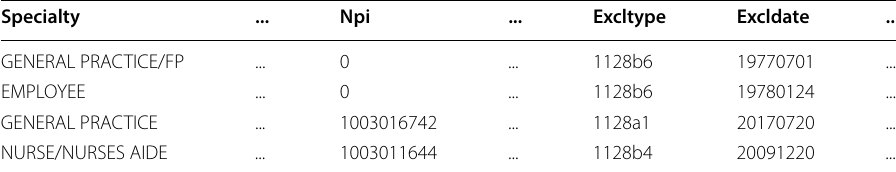
Table 4 Sample of LEIE